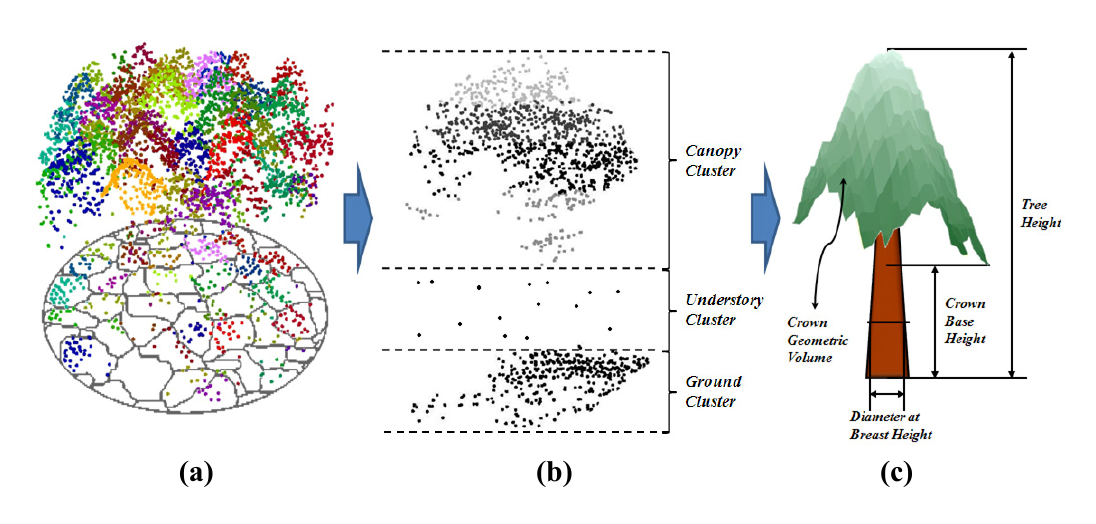
Figure 3. Classification of ALS data according to individual trees segmented using the Kwak et al . method [5] (a) , result of k -means clustering for ALS data reflected from individual tree spaces (b) , and CGV generated from crown returns (c)